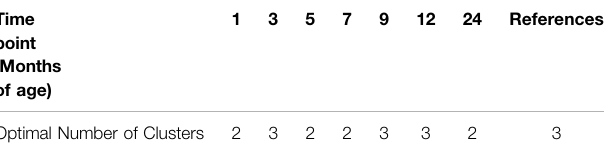
TABLE 1| Optimal numberofclustersselectedautomaticallyinCronosforall time points. The fi rst row represents the time point in months of age, whereas the second shows the different number of similar microbiome pro fi les.